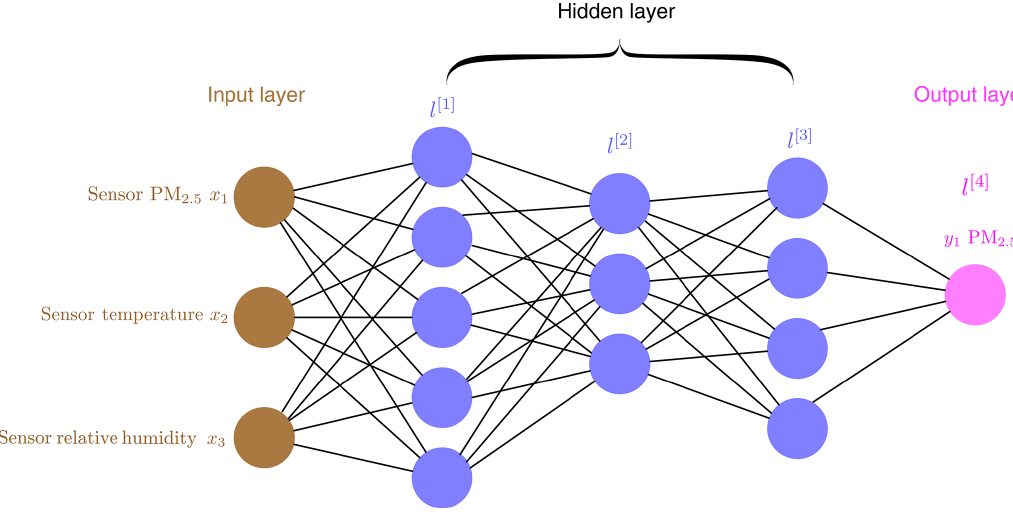
Figure 3. Example of a neural network